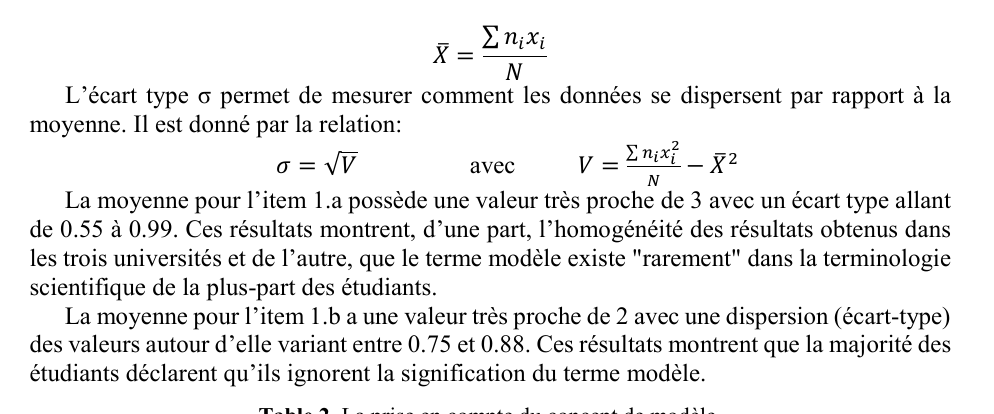
Table 2. La prise en compte du concept de